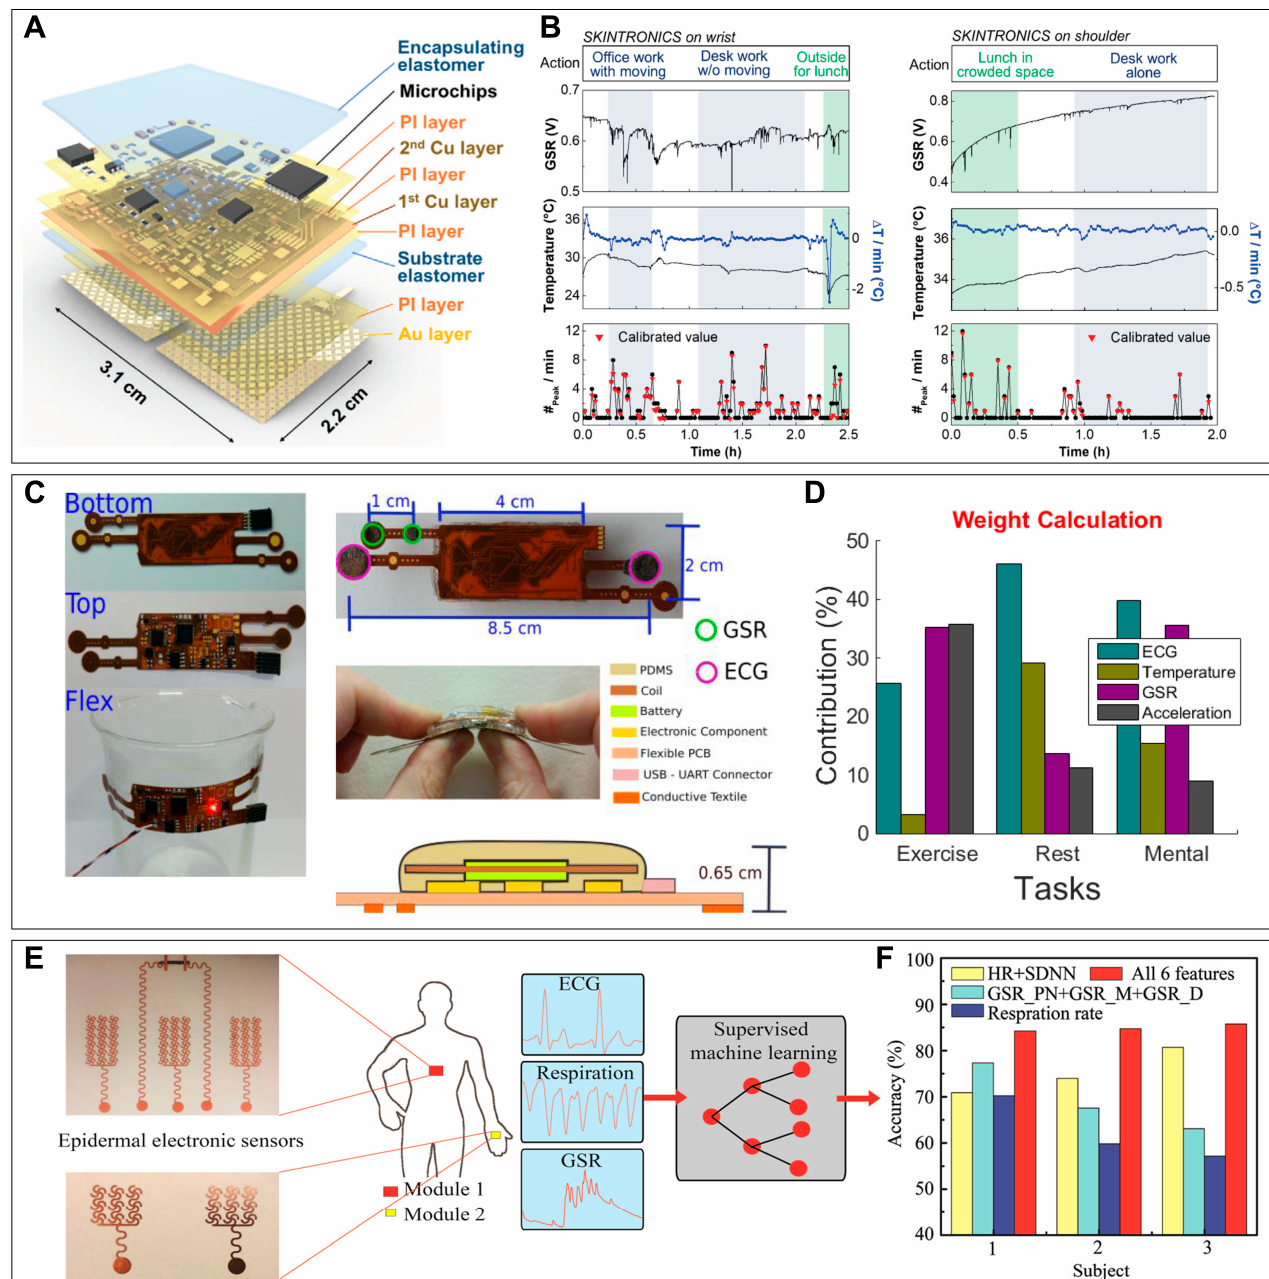
Figure 2. Multiplexed physical sensor systems. Stress monitoring through the acquisition and anal- ysis of physiological signal data through the multiplexed physical sensor. ( A ) GSR and ST detection through SKINTRONICS and ( B ) stress analysis under various environments [83]. ( C ) The device, fabricated using a flexible printed circuit board to produce ECG and measure GSR; ( D ) its detection of various physiological signals when exercising, resting, and performing mental tasks, and their analysis for stress monitoring [84]. ( E ) The epidermal sensors that can produce ECG and measure RR and GSR, and ( F ) comparison of mental fatigue detection accuracy using multimodal sensors and a single sensor [85].